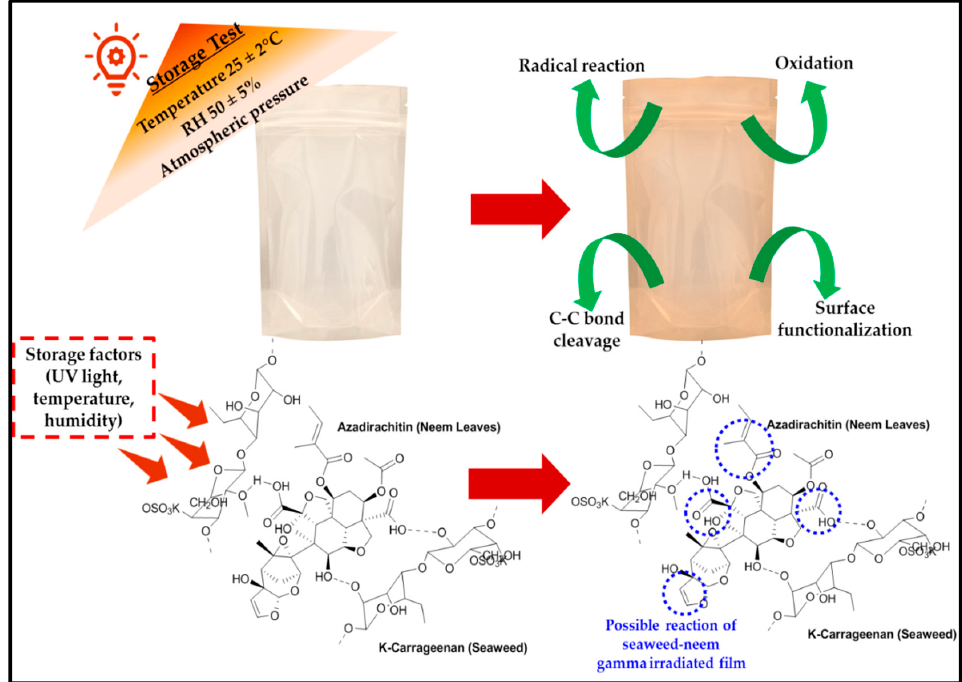
Figure 7. Schematic representing possible mechanistic action of the irradiated biofilms for active packaging. The antimicrobial activities of the films were measured using the agar diffusion method with film in a disc shape. The diameter of inhibitory zones surrounding the film discs was used to evaluate the inhibitory and antimicrobial activities of the irradiated films [67]. The antimicrobial activities of the seaweed-based films tested against Staphylococcus aureus , and Bacillus subtilis is indicated in Figure 8. As expected, the seaweed film (control) exhibited no inhibitory zones against the tested bacteria. However, the incorporation of 5% w / w neem leaves extract into the control film demonstrated inhibitory activities against Staphylococcus aureus and Bacillus subtilis with the diameter of inhibition zone of 12.61 ± 0.27 mm and 8.92 ± 1.09 mm, respectively [68], suggesting that the difference in the antimicrobial activities against bacteria was attributed to the lipid bilayer composition of bacterial strains and the degree of depolarization and permeability of the cell walls [69]. In addition, the antimicrobial activity of neem leaves extract-based seaweed films might be due to the presence of effective components such as carotenoids, phenolic compounds, flavonoids, triterpenoids, ketones, valavinoids, saponins, gilcosides, steroids, and tetra-triterpenoids azadirachtin in the neem leaves [21]. This could be attributed to the essential components of incorporated neem extracts in the seaweed matrix, which served as the principal antibiotics that could serve as a defensive mechanism against different pathogens [70]. However, the irradiation of the seaweed–neem films at different dosages exhibited increased inhibitory zones against Staphylococcus aureus and Bacillus subtilis until a radiation dosage of 1.5 kGy was applied. It can be inferred that an increase in irradiation dosage significantly enhanced the antimicrobial activities of the films against Staphylococcus aureus compared to Bacillus subtilis. Similarly, the irradiation of the films resulted in the induced free radicals in the film as a result of increased bonding interactions between neem extracts in the seaweed matrix in the film structure, thereby enhancing the antimicrobial activity of the film [71]. Although the films exhibited a less inhibitory effect against the investigated bacteria after an irradiation dosage of 2 kGy was applied compared to the effect of other irradiation